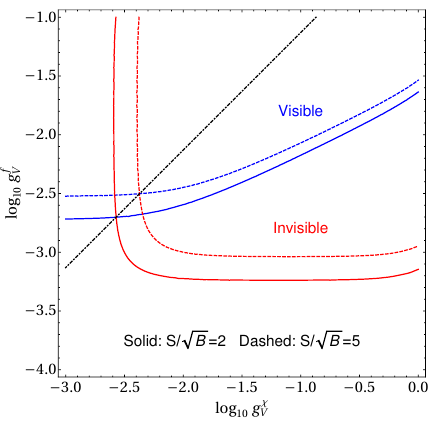
Figure 14 . The CEPC sensitivity on the g (cid:31) - g f plane in the H -mode via the monophoton channel V V e + e (cid:0) ! (cid:13)Z 0 ! (cid:13)(cid:31)(cid:31) (the invisible channel), and via the dimuon channel e + e (cid:0) ! (cid:13)Z 0 ! (cid:13)(cid:22) + (cid:22) (cid:0) (the visible channel). We consider the vector coupling only case with M Z 0 = 150 GeV and m (cid:31) = 50 GeV. The upper bounds in the visible (invisible) channel are shown in blue (red) lines assuming 5.6 ab (cid:0) 1 data in the H -mode; the solid (dashed) lines indicate the 2 (cid:27) (5 (cid:27) ) reaches. The black dot-dashed line divides the parameter space into two regions: the invisible (visible) channel is the better channel in the region below (above) the black line. Here only di-muon events in the invariant mass window 150 (cid:6) 3 GeV are